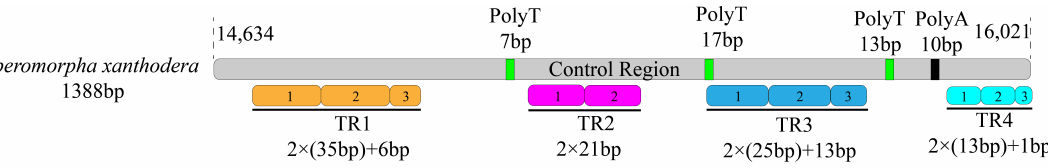
Figure 5. A + T-rich region of Luperomorpha xanthodera mitogenome. Gray blocks represent the A + T rich region. The numbers at the beginning and end of the gray blocks show the position of the control region in the Luperomorpha xanthodera mitogenome. R stands for repeat unit, and the number denotes the number of repeats. The black and green blocks represent the structures of poly-A and poly-T,